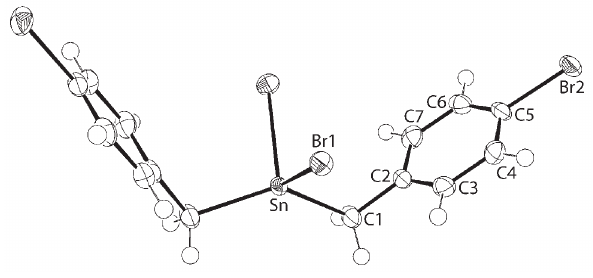
Table 1: Data collection and handling.